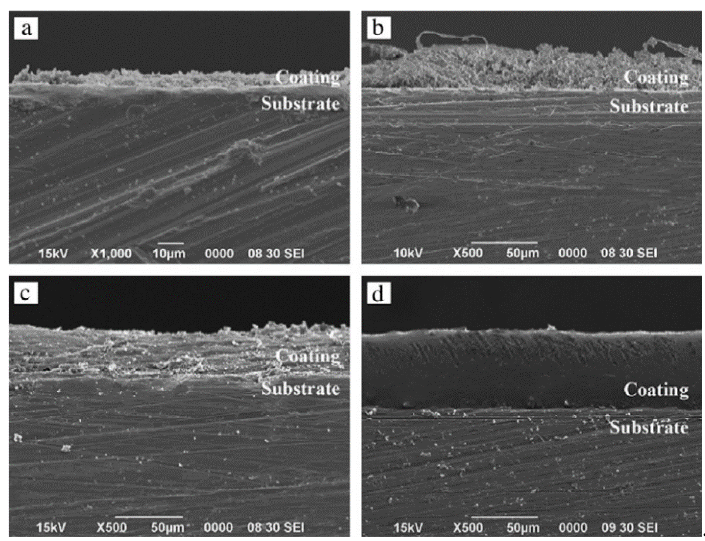
Figure 8. SEM images of the cross-section of ( a ) HA, ( b ) 10% PCL/HA, ( c ) 30% PCL/HA, and ( d ) 50% PCL/HA [91], reprinted with permission from Elsevier.